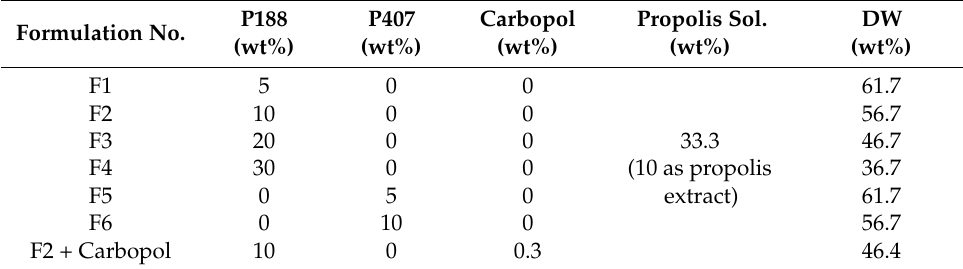
Table 2. Compositions of propolis-poloxamer formulations. Formulation